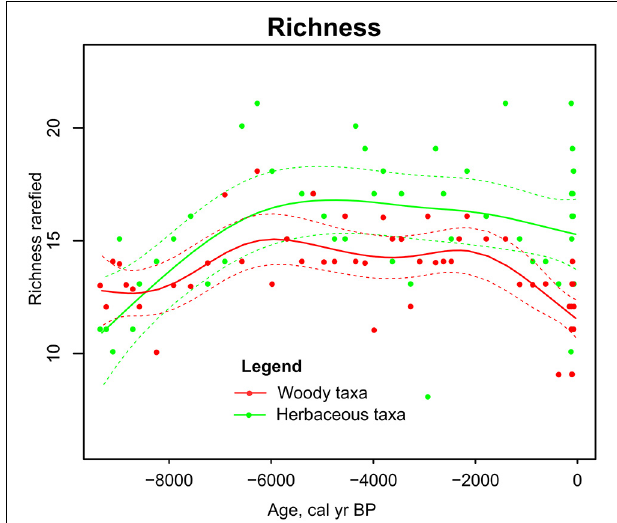
FIGURE 4 | Sedimentary pollen based richness in Kanna spring fen. Generalized additive model of herbaceous taxa (green line) and woody taxa (red line) in time. Dashed lines enclose the 95% confidence intervals of trend lines.